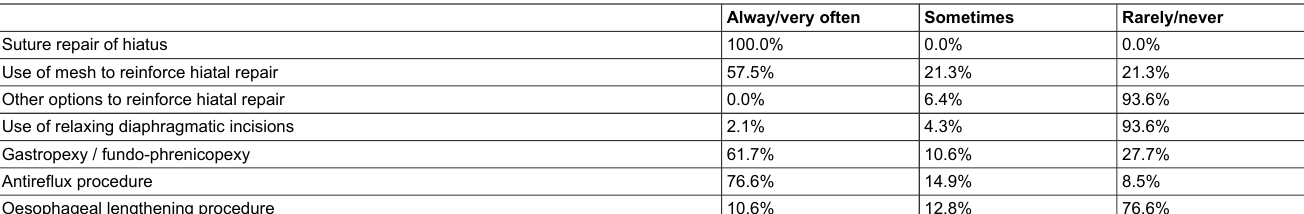
Table 4: Technical details of hiatal reconstruction.